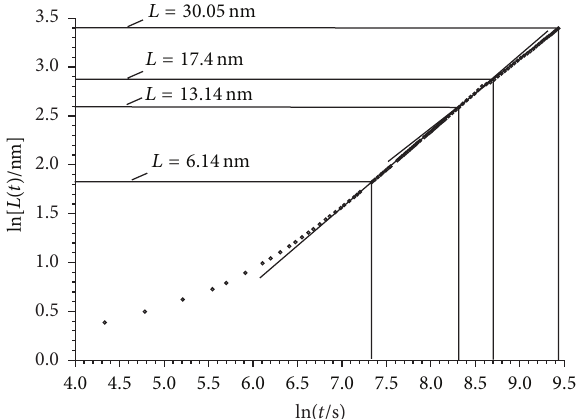
Figure4:Oxidethicknessln [𝐿(𝑡)/ nm ] versusoxidationtimeln (𝑡/ s ) relation for Blanc’s data set A11 (cp. Tables 1 and